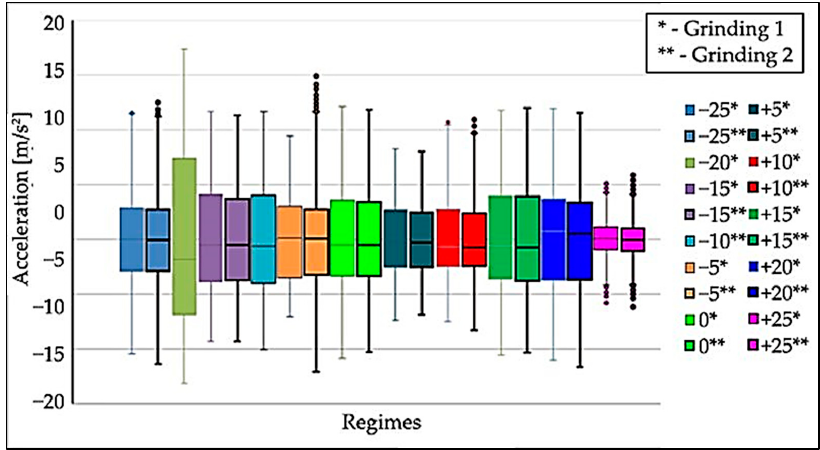
Figure 10. Boxplots of the acceleration of the oscillation in the tested modes on the ruler in the “ x -axis” direction, grinding wheel speed—1907.2 [rpm], basic speed (regime 0) for regulating wheel— 20.2 [rpm], workpiece speed—254 [rpm], ruler distance—13 [mm].